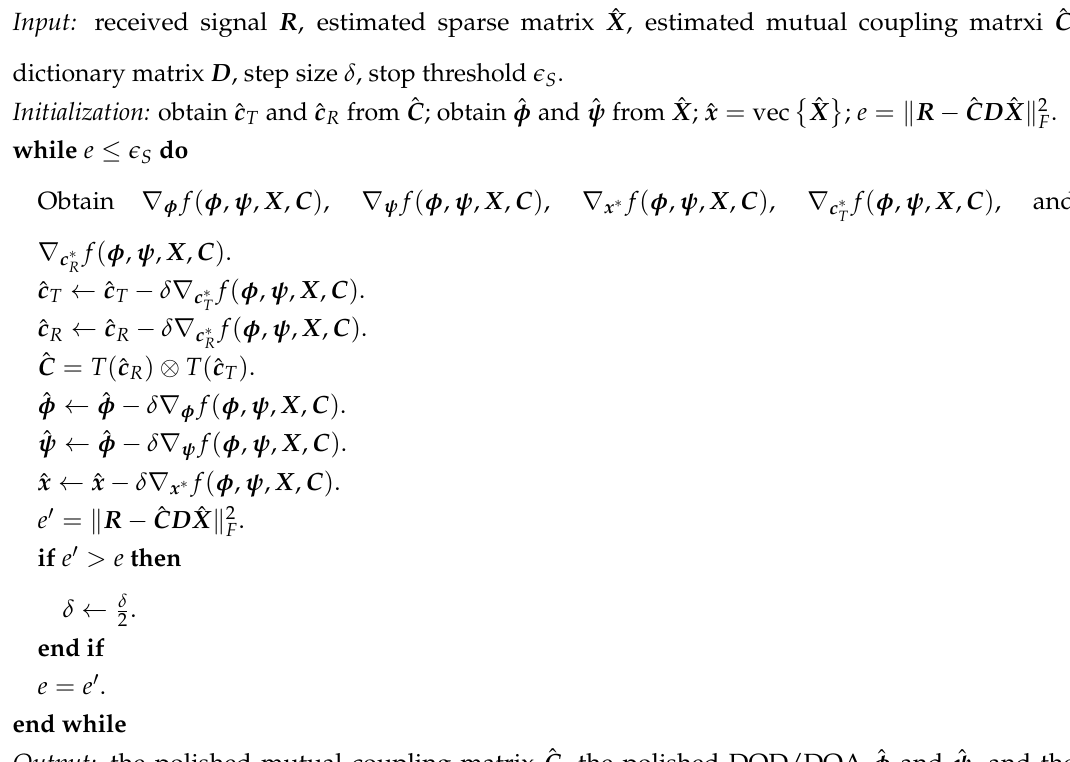
Algorithm 3 Polish the estimated DOD/DOA and mutual coupling